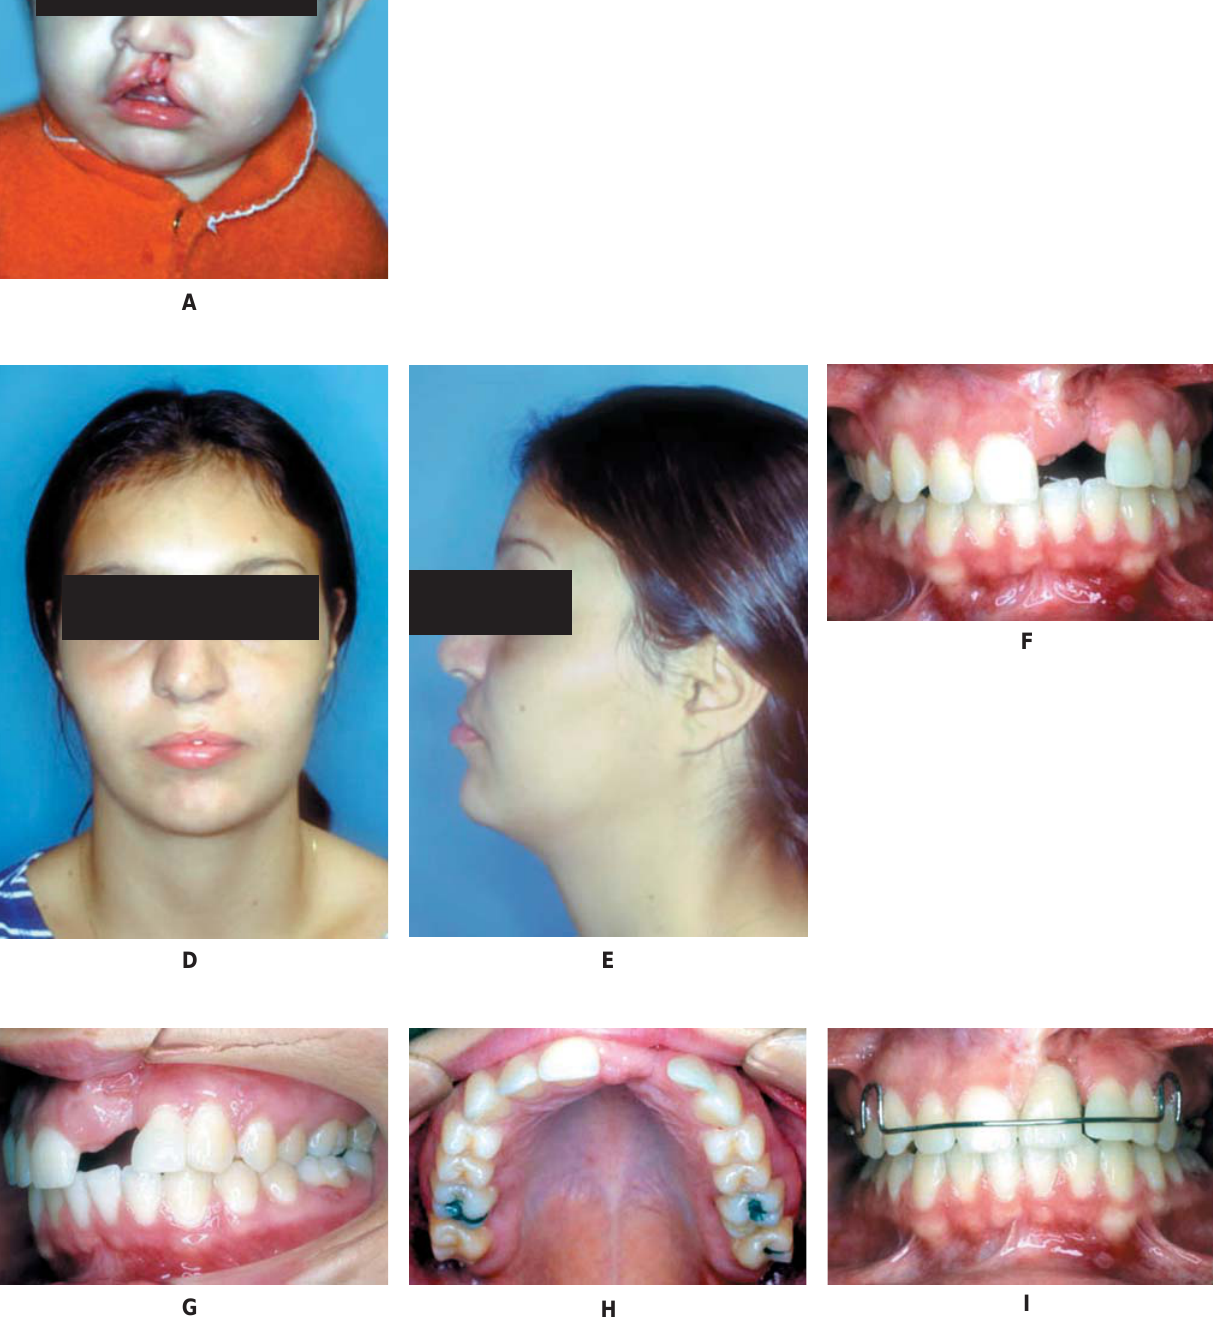
FIGURE 4- Patient with cleft lip and alveolus. A) to C) complete unilateral cleft lip and alveolus. D) and E) facial analysis in adulthood after rehabilitation at HRAC/USP demonstrating that the maxilla is well positioned in the face (Pattern I). F) to I) intraoral views after rehabilitation at